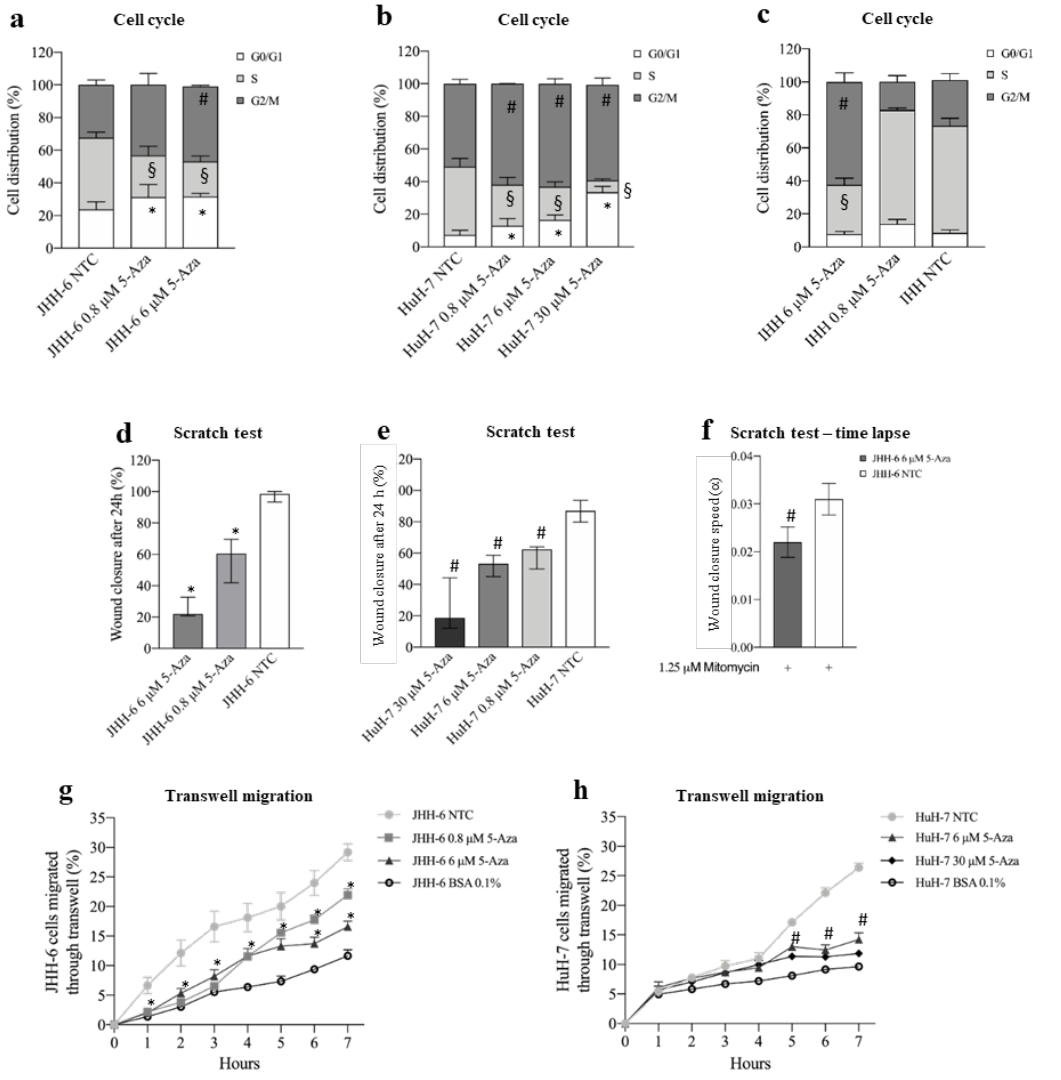
Figure 1. Effects of 5-Aza on cell growth and migration. ( a – c ) Cell cycle phase distribution. Data, expressed as mean ± SEM, are reported as percentage. JHH-6 NTC G0/G1 vs. JHH-6 0.8/6 μ M 5-Aza G0/G1, * p < 0.021; JHH-6 NTC S vs. JHH-6 0.8/6 μ M S, § p < 0.0087; JHH-6 NTC G2/M vs. JHH-6 0.8/6 μ M G2/M, # p < 0.011, n = 5. HuH-7 NTC G0/G1 vs. HuH-7 0.8/6/30 5-Aza μ M G0/G1, * p < 0.022; HuH-7 NTC S vs. HuH-7 0.8/6/30 5-Aza μ M S, § p < 0.024; HuH-7 NTC G2/M vs. HuH-7 0.8/6/30 μ M G2/M, # p < 0.045, n = 3. IHH NTC S vs. IHH 6 μ M 5-Aza S, § p < 0.0003; IHH NTC G2/M vs. IHH 6